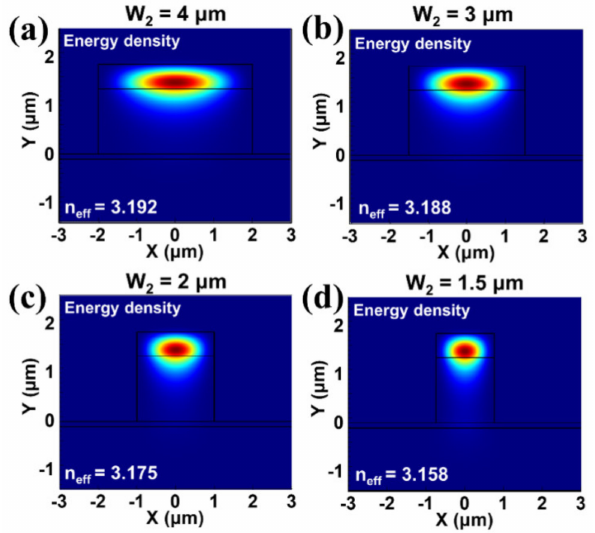
Figure 10. ( a ) The 2D mode profile with W 2 = 4 µ m. ( b ) The 2D mode profile with W 2 = 3 µ m. ( c ) The 2D mode profile with W 2 = 2 µ m. ( d ) The 2D mode profile with W 2 = 1.5 µ